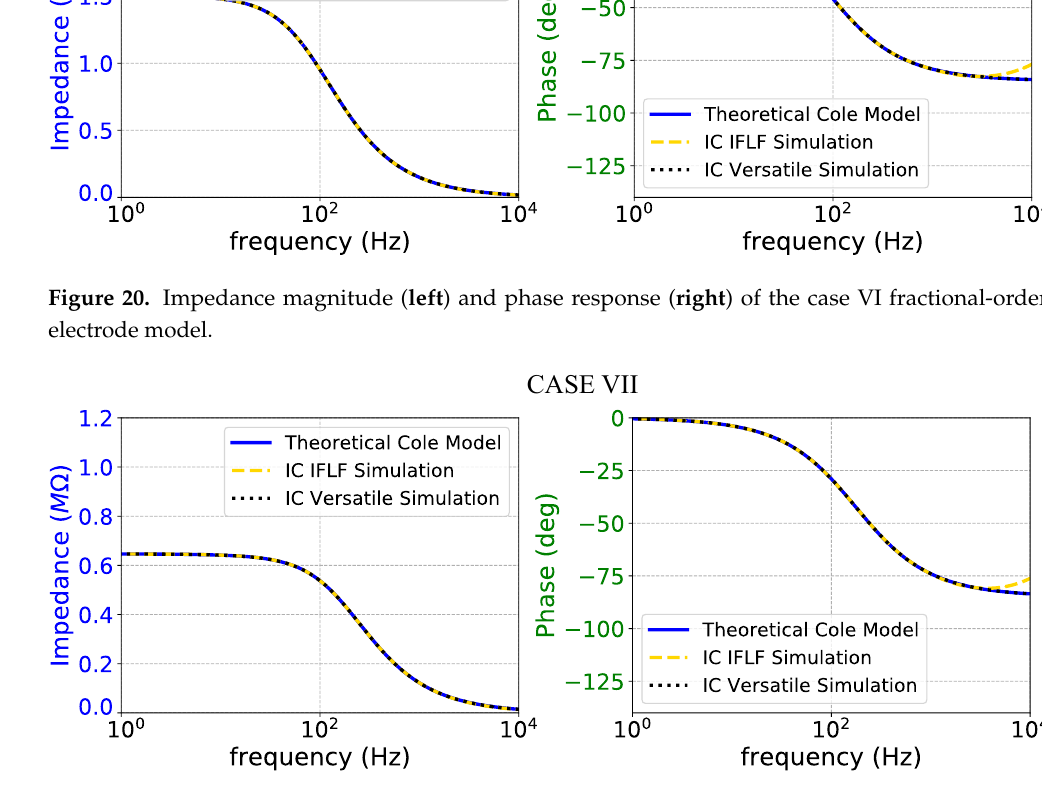
Figure 21. Impedance magnitude ( left ) and phase response ( right ) of the case VII fractional-order electrode model.